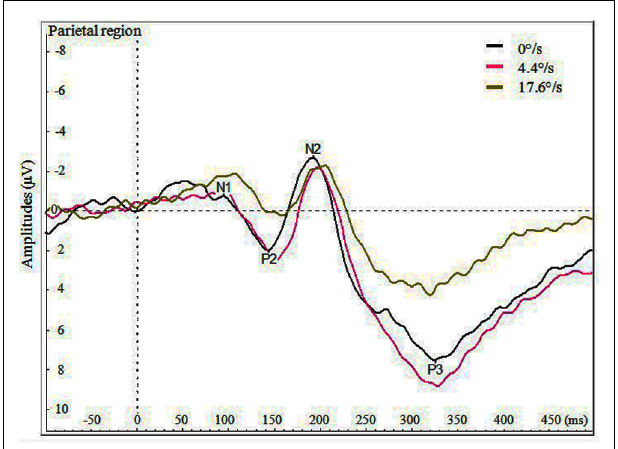
FIGURE 3 |AverageVEPs for the color change in the parietal region by three velocities (0, 4.4, and 17.6 ◦ /s).